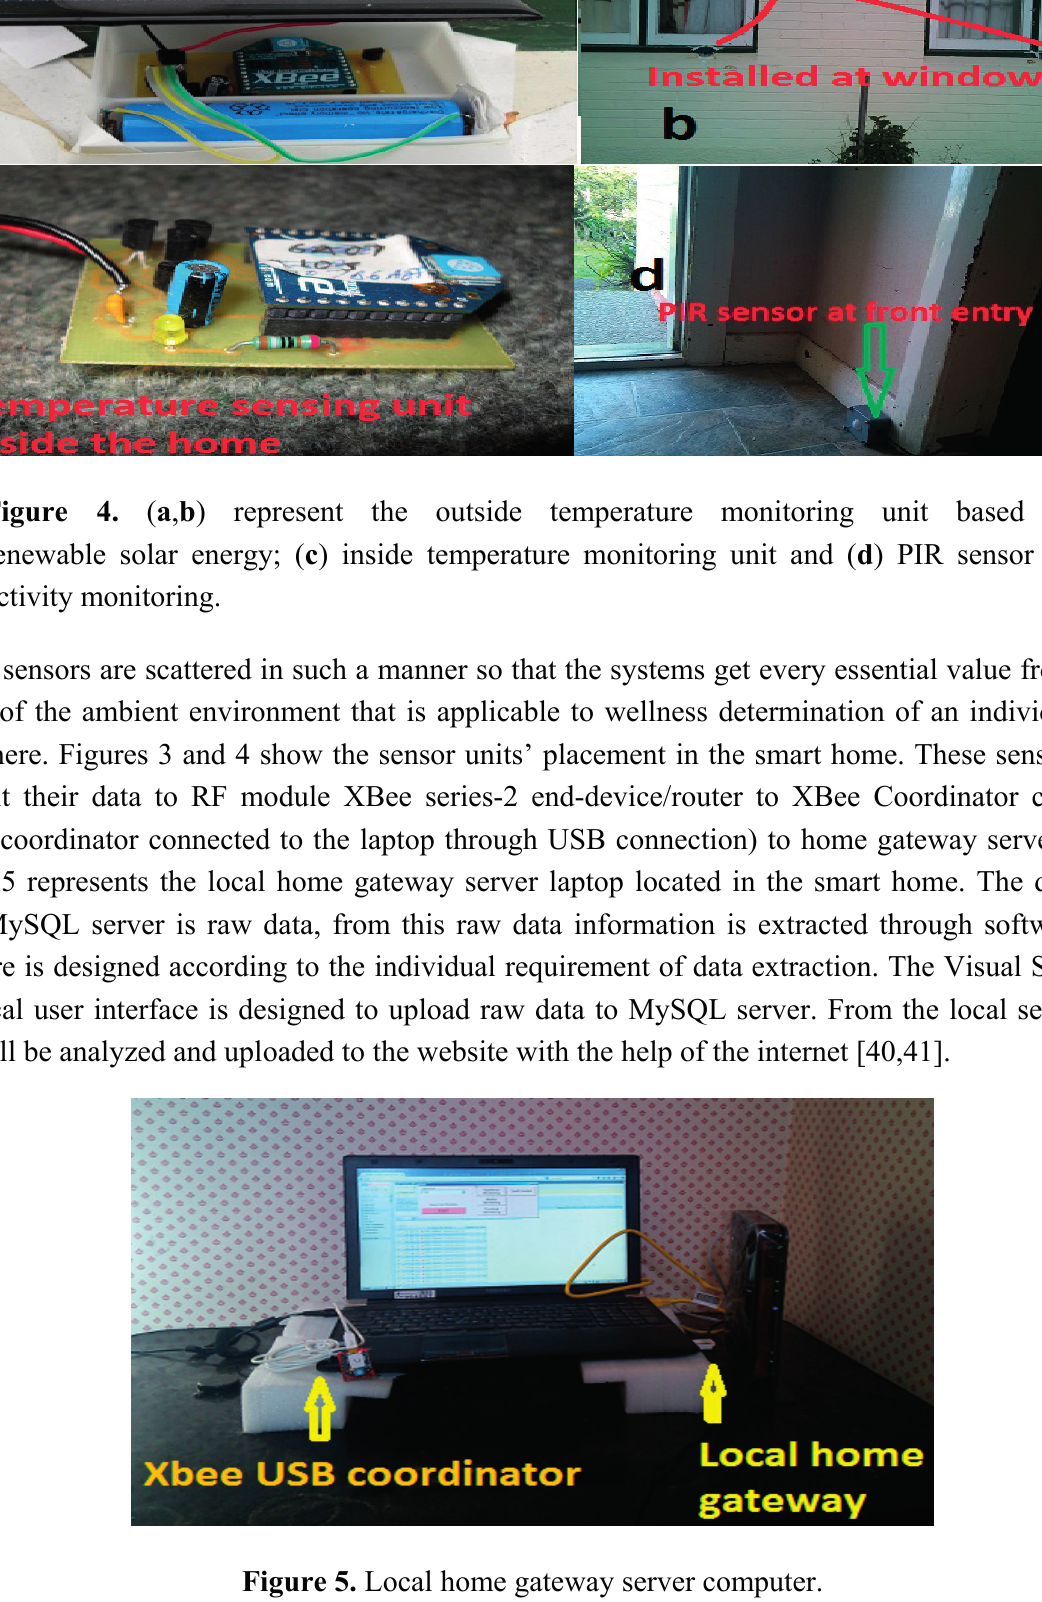
Figure 5. Local home gateway server